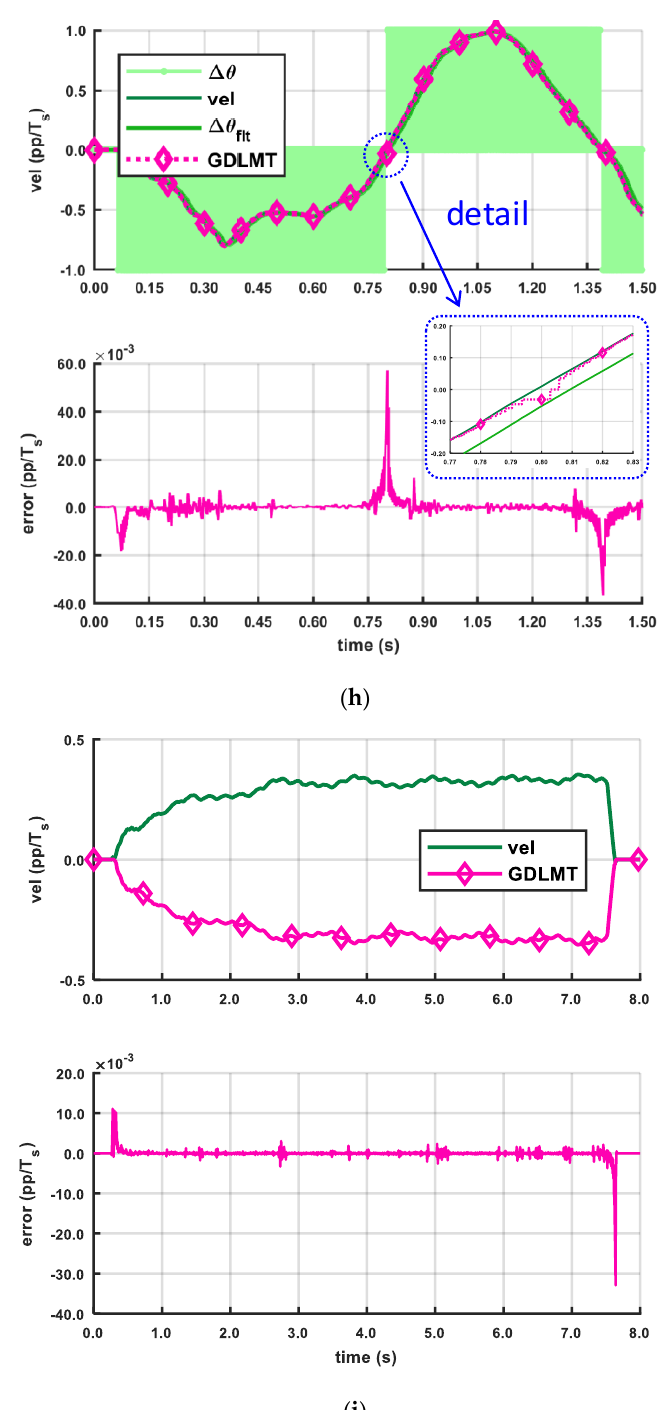
Figure 13. Experiments with non-motorized encoder driving at medium and low speed: ( a , d , g ) abrupt manual start up followed by self-slowdown; ( b , e , h ) manual sinusoidal-like motion; ( c , f , i ) driving by gravitational load at near-constant very low speed.